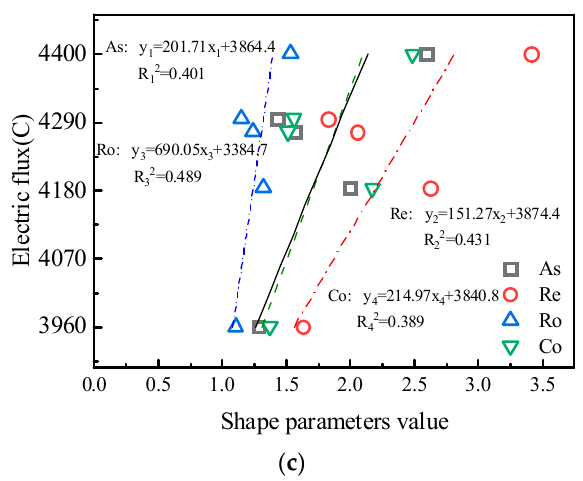
Figure 22. Correlations between particle shape parameters and electric flux of concrete: ( a ) angular-